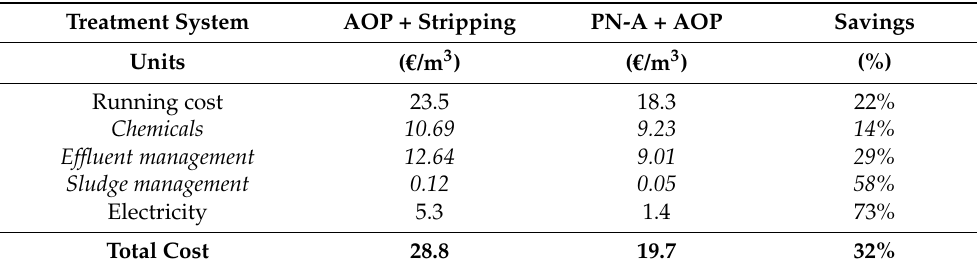
Table 3. Operational cost analysis for the treatment of the leachate produced in the CORSA land- fill site. Comparison of the old technology (based on AOP + stripping-scrubbing) with the new technological approach (based on PN-A + AOP).